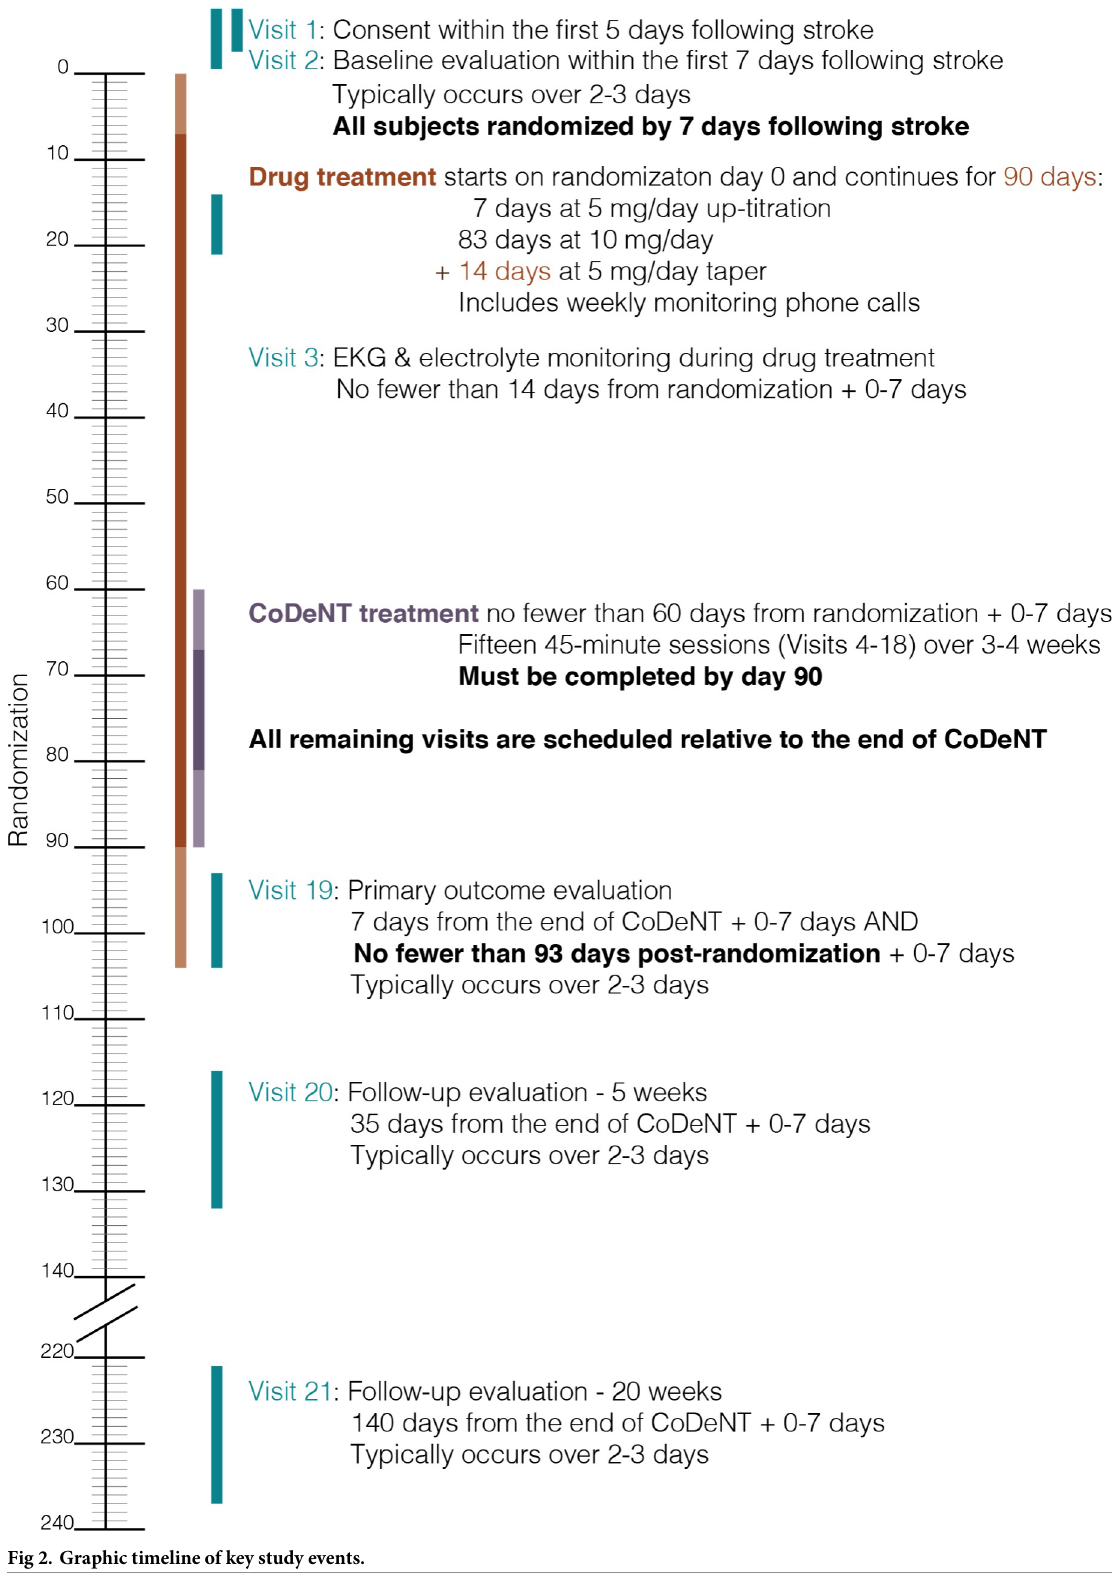
Fig 2. Graphic timeline of key study